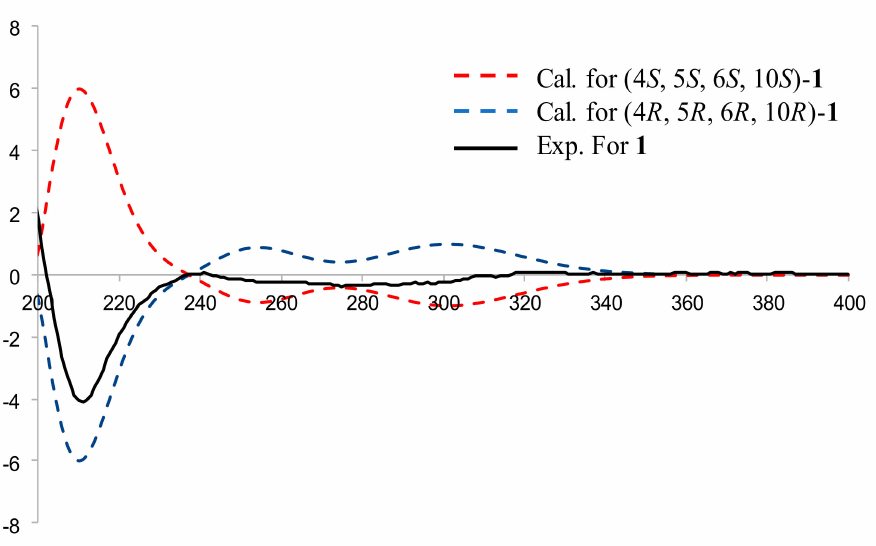
Figure 4. Comparison of the calculated ECD spectrum for (4 S , 5 S , 6 S , 10 S )- 1 at B3LYP/6-31G(d) level with the experimental spectrum of 1 in MeOH. σ = 0.3 eV, shift = − 10 nm.